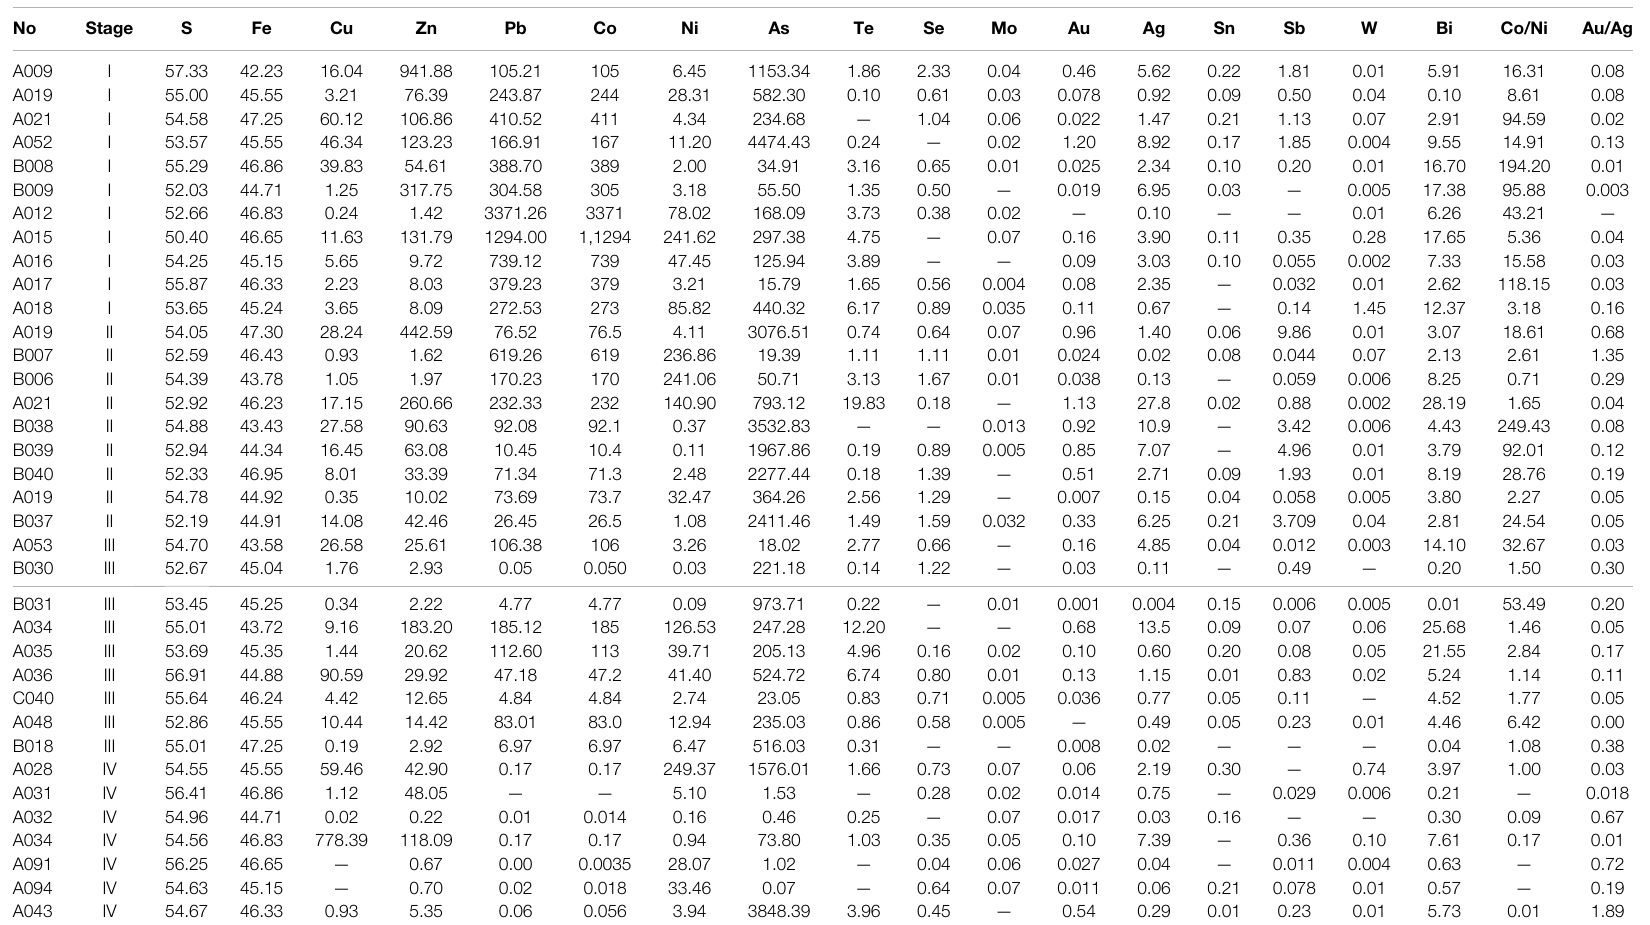
TABLE 2 | Pyrite trace element compositions of the Zhaoxian gold